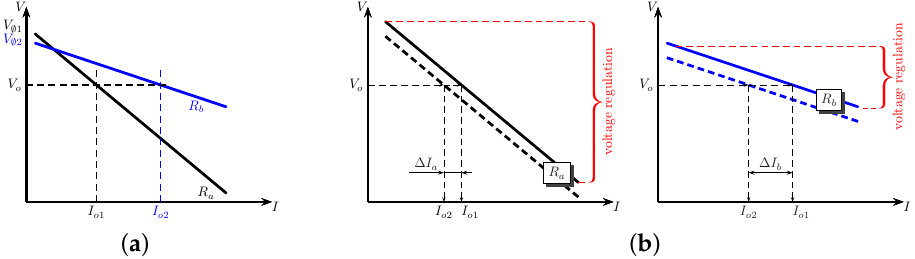
Figure 1. Output characteristics for two parallel connected modules with an added resistor at the output: ( a ) different values; ( b ) same values ( R a on the left and R b on the right when R a > R b